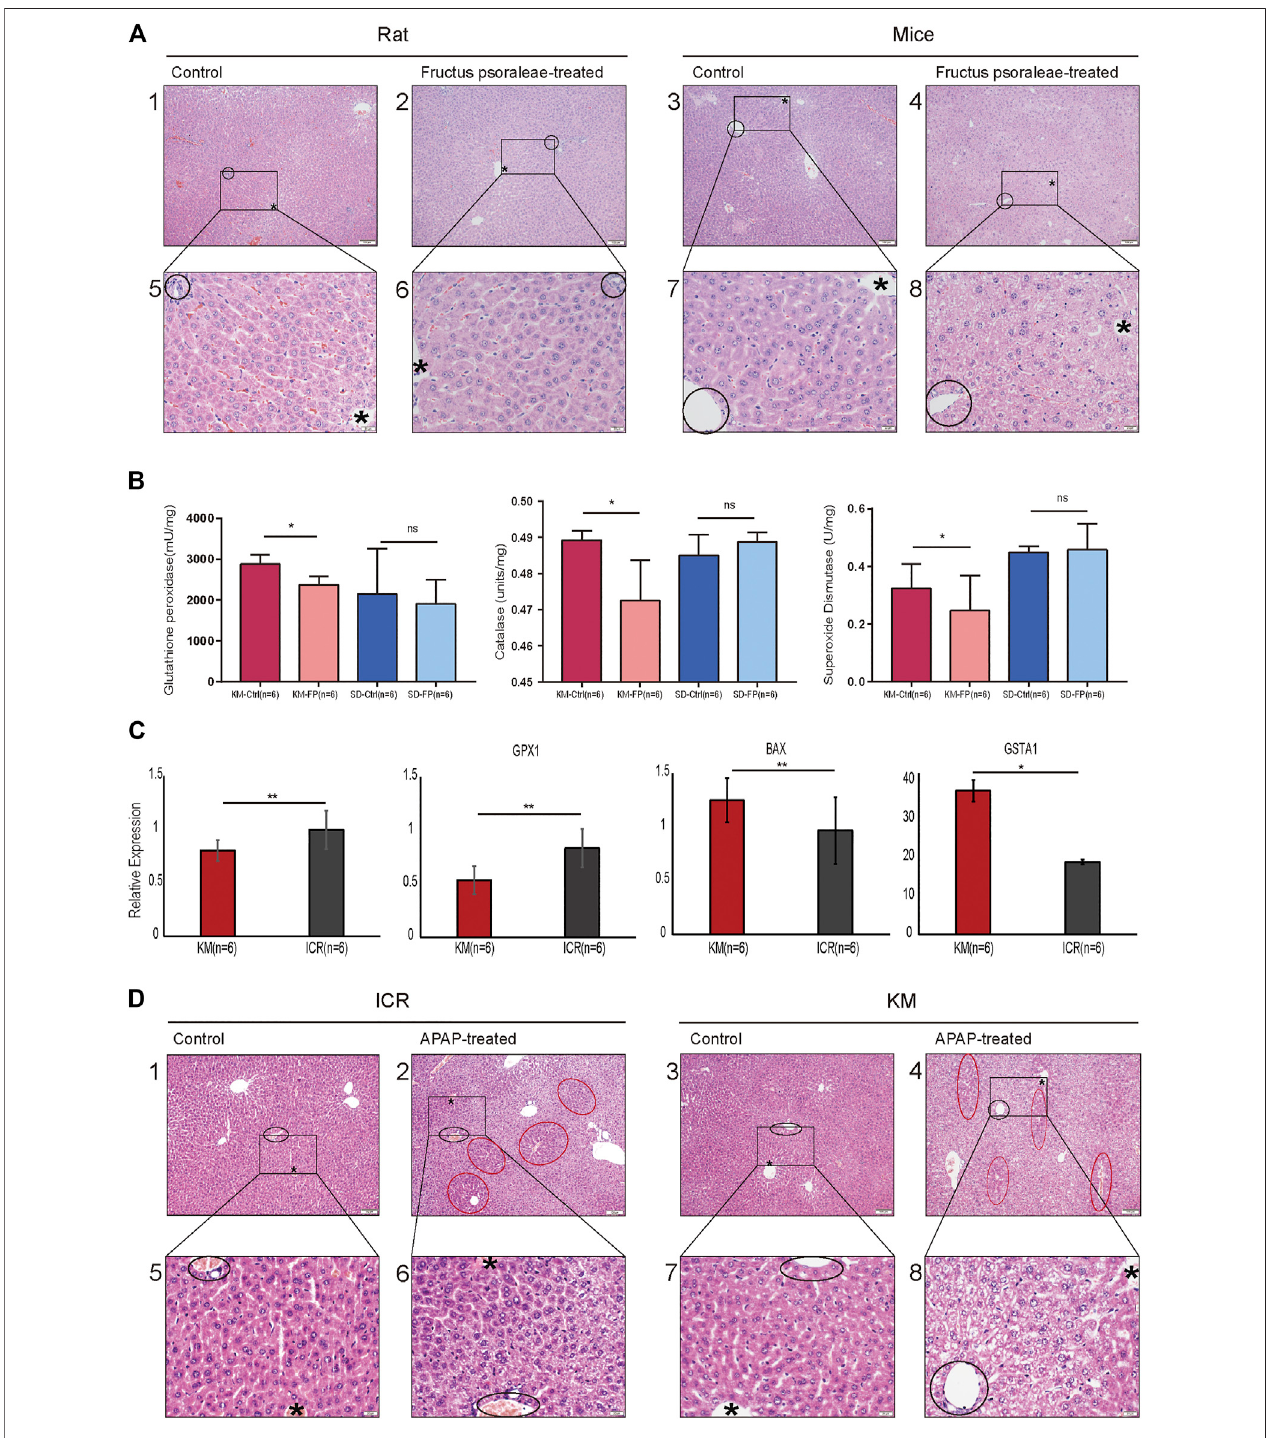
FIGURE 4 | Histopathological studies and gene expression con fi rmed that Kunming mice were better suited for the study of oxidative stress-related DILI. (A) Liver HEsectionofratsandmicetreatedwiththesamedoseoffructuspsoraleaefor1month.Scalebar:1 – 4:100 μ m,5 – 8:20 μ m, “ * ” isthehepaticlobularvein,blackcircleis the hepatic lobular portal area; (B) Glutathione peroxidase, catalase, and total superoxide dismutase assays in fructus psoraleae-treated Kunming mice and Sprague- Dawleyrats. (C) RelativeexpressionlevelofSOD1,GPX1,BAX,andGSTA1inKunmingandICRmicetreatedwiththesamedose(400 mg/kg)ofAPAPfor5days; (D) LiverHEsectionsofKunmingandICRmicetreatedwiththesamedose(400 mg/kg)ofAPAPfor5days.Scalebar:1 – 4:100 μ m,5 – 8:20 μ m, “ * ” isthehepaticlobular vein, black circle is the hepatic lobular portal area, and red circle represents the region of normal hepatocytes.